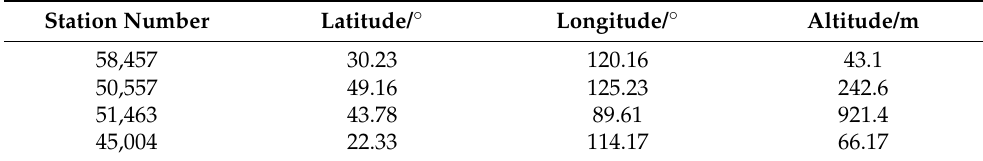
Table 5. The information of the four stations.